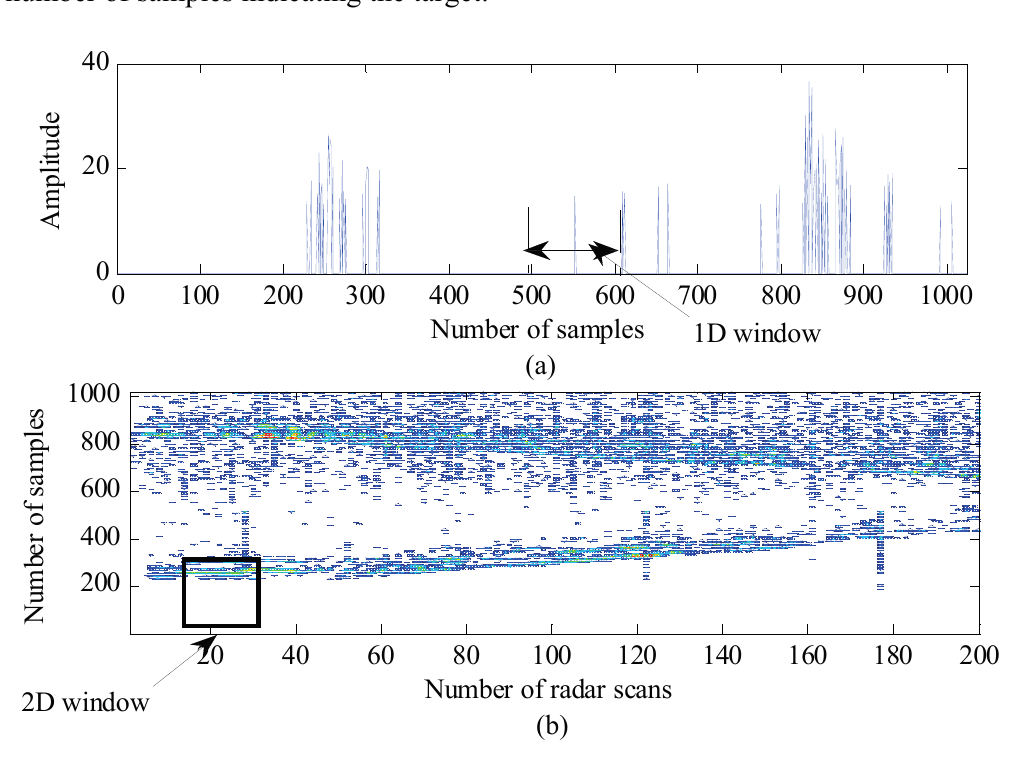
Figure 4 . Jumping-window method for eliminating false alarms: ( a ) one-dimensional (1D) window and ( b ) two-dimensional (2D)